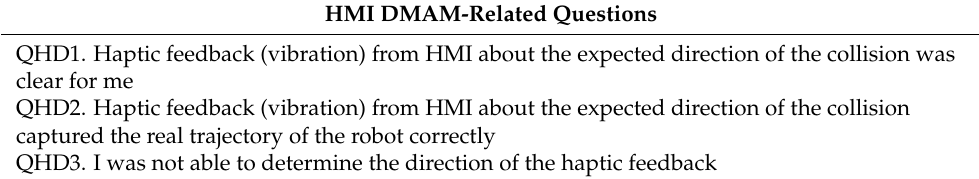
Table 4. Questions related to HMI with directional feedback